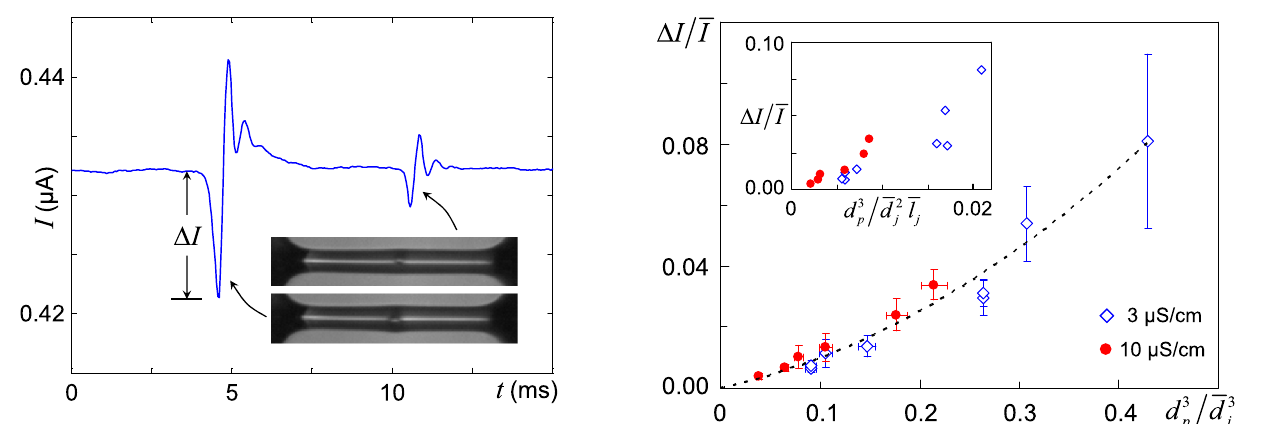
FIG. 7. Polystyrene particles were detected with the relative (cid:2) I (cid:2) I with strong current change ( (cid:3) I= ) indicative of the ratio of the particle (cid:2) d 3 volume ( V p (cid:2) d 3 p ) to the sensing volume ( V s (cid:2) j ). The vertical error bars are 95% confidence intervals of repeated measure- ments, while the horizontal ones are based on manufacturer specifications. For the dashed quadratic curve fit passing through the origin [Eq. (4)], (cid:6) ¼ 0 : 0719 , (cid:7) ¼ 0 : 269 , and the coefficient of determination ( R 2 ) is 0.963. In the inset, the relative current change correlates poorly with the particle-to-jet volume ratio, supporting the conclusion that the sensing volume is governed (cid:2) l (cid:2) d 2 not by the volume of the jet ( j ) but by the volume of the j (cid:2) d 3 conical apex ( j ).